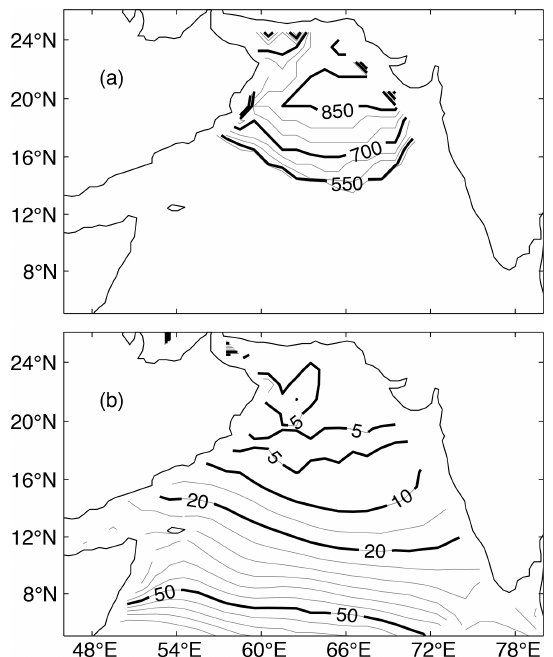
Figure 4. (a) Thickness (in metres) of the layer containing an oxy- gen concentration less than 10µmolkg − 1 based on climatological data from WOA13. (b) Oxygen concentration (µmolkg − 1 ) on the σ = 27kgm − 3 isopycnal of WOA13.